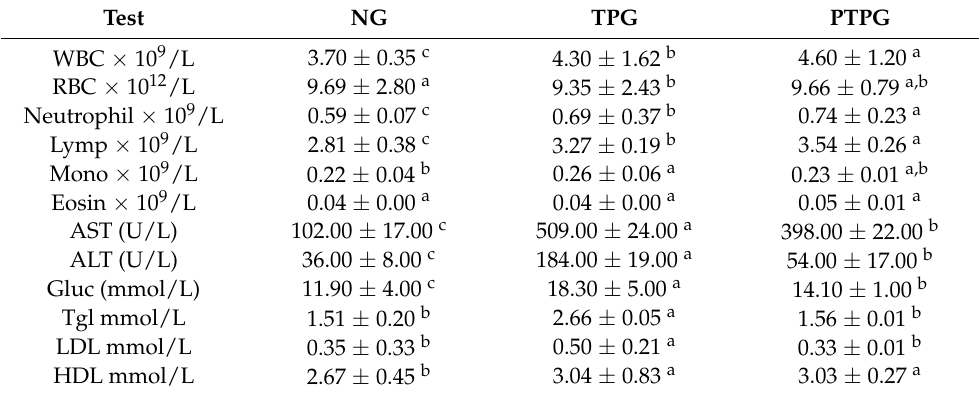
Table 7. The biochemical examination results of the blood obtained from the different mice